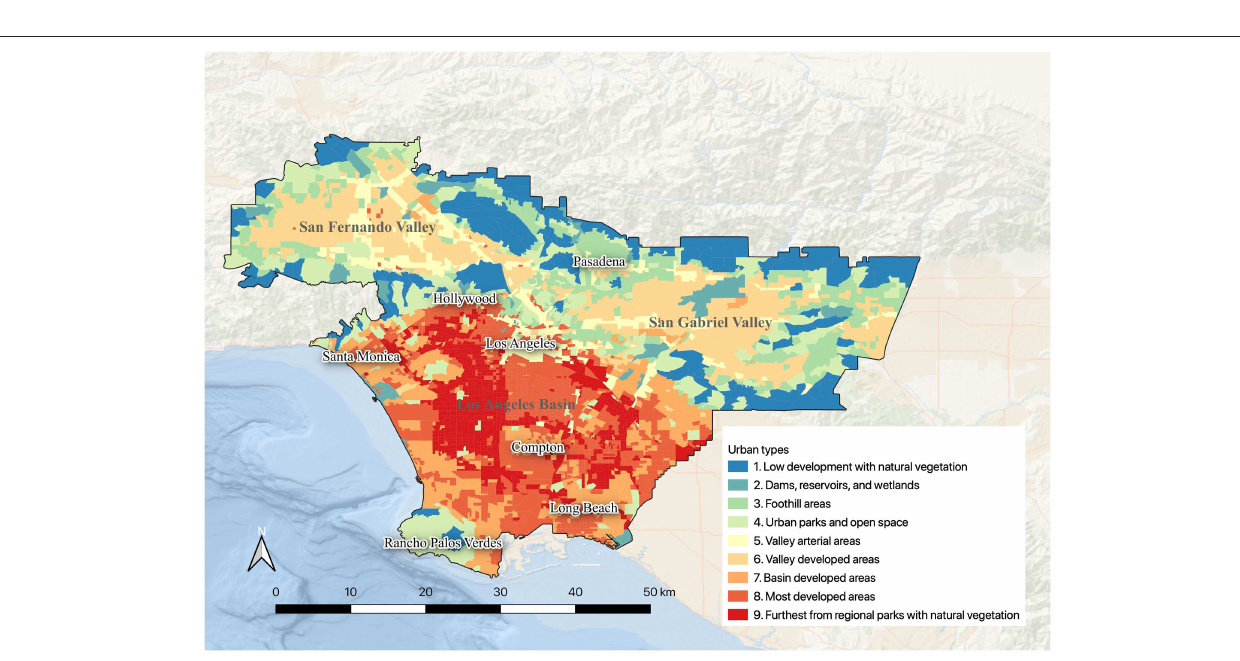
FIGURE 3 | Dendrogram showing the hierarchical clustering of Census Block Groups and the distance among clusters in multivariate data space. The gap statistic (upper right) showing the total within-cluster variation for different values of k; the number of optimal clusters was determined by identifying at which point the rate of increase of the gap statistic began to slow down. Refer to Figure 4 for definitions of the nine urban habitat types.